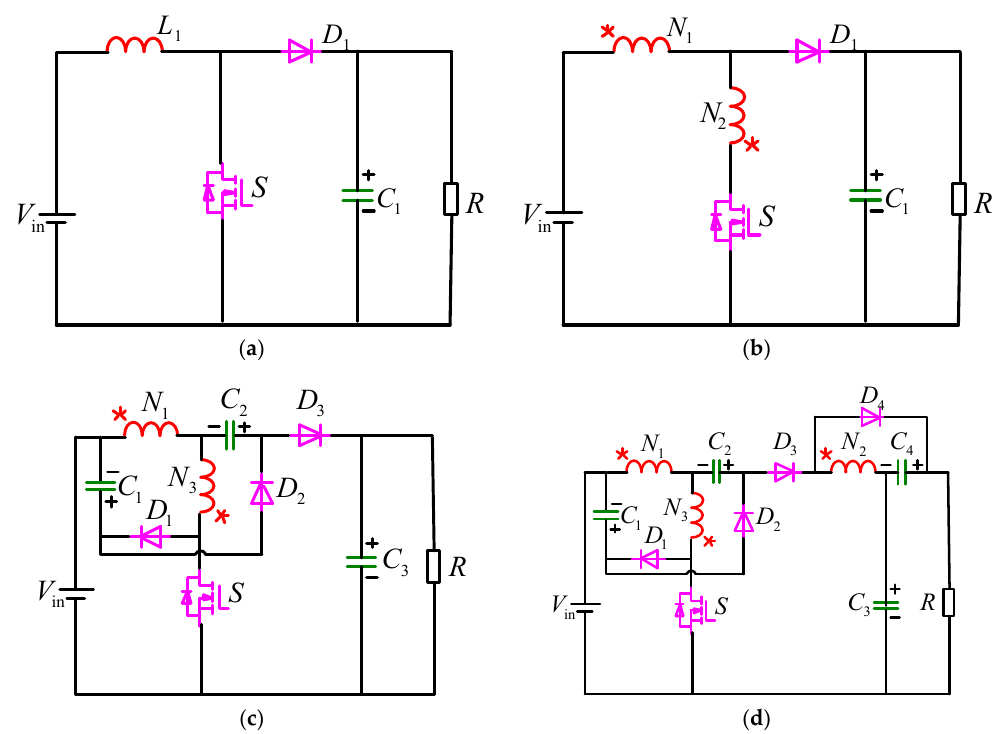
Figure 1. The integration processes of the proposed converter: ( a ) boost converter; ( b ) two-winding coupled inductor boost converter; ( c ) two-winding coupled inductor boost converter with voltage-double capacitors; and ( d ) proposed three-winding coupled inductor high step-up converter.